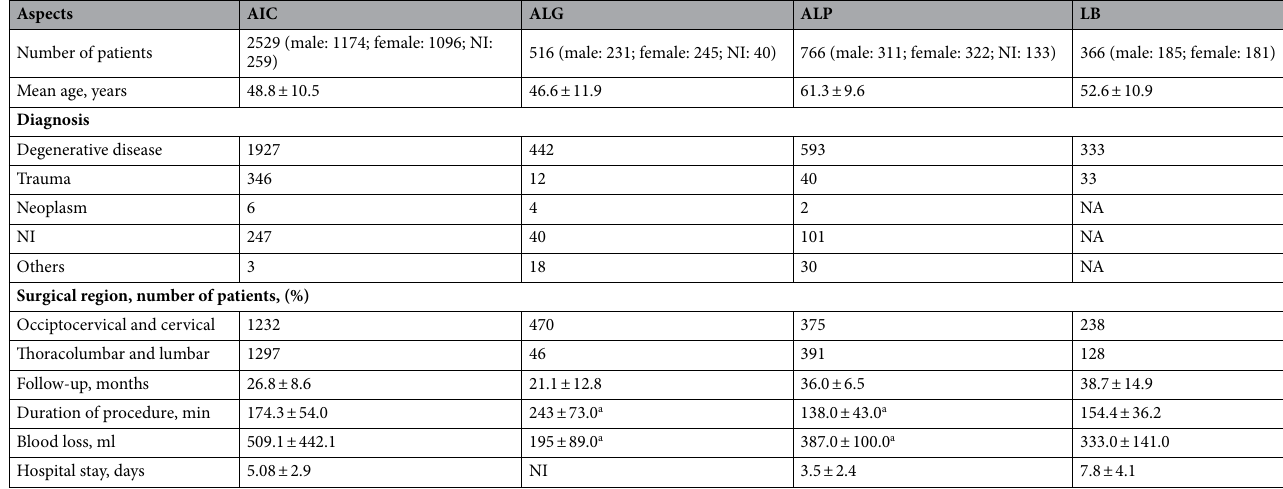
Table 2. Patient’s characteristics and clinical outcomes. AIC Autologous iliac crest, ALG allograft, ALP alloplastic, LB local bone, NA not applied, NI not informed. a Cited in one